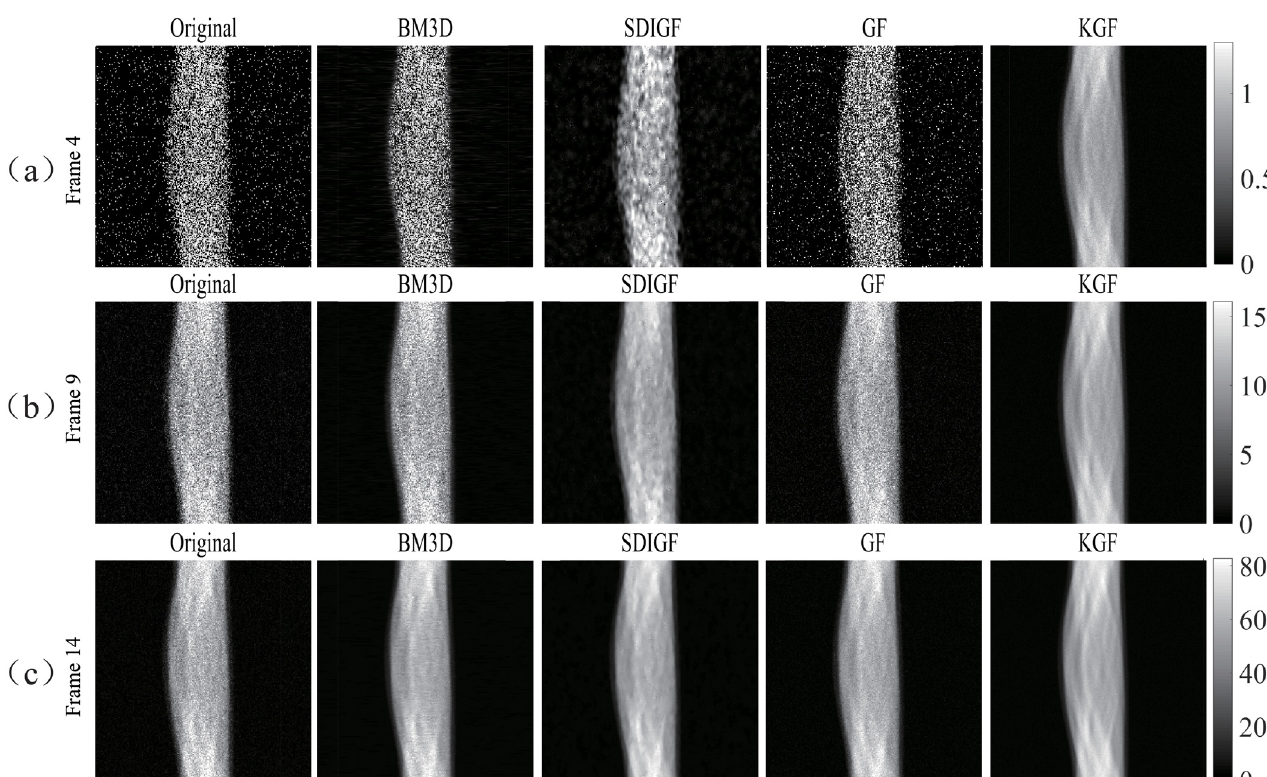
Fig 11. In vivo sinograms denoised by different methods for (a) low count frame 4, (b) middle count frame 9, (c) high count frame 14. Original column: original sinograms, other columns: sinograms denoised by respective methods.